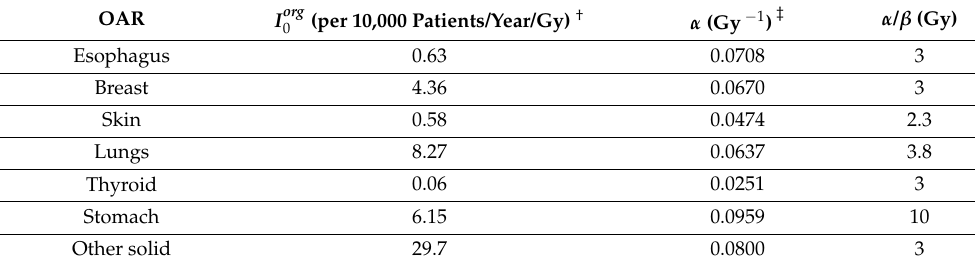
Table 3. Values of the parameters used for cancer risk estimations for all considered OARs. OAR I org (per 10,000 Patients/Year/Gy) † 0